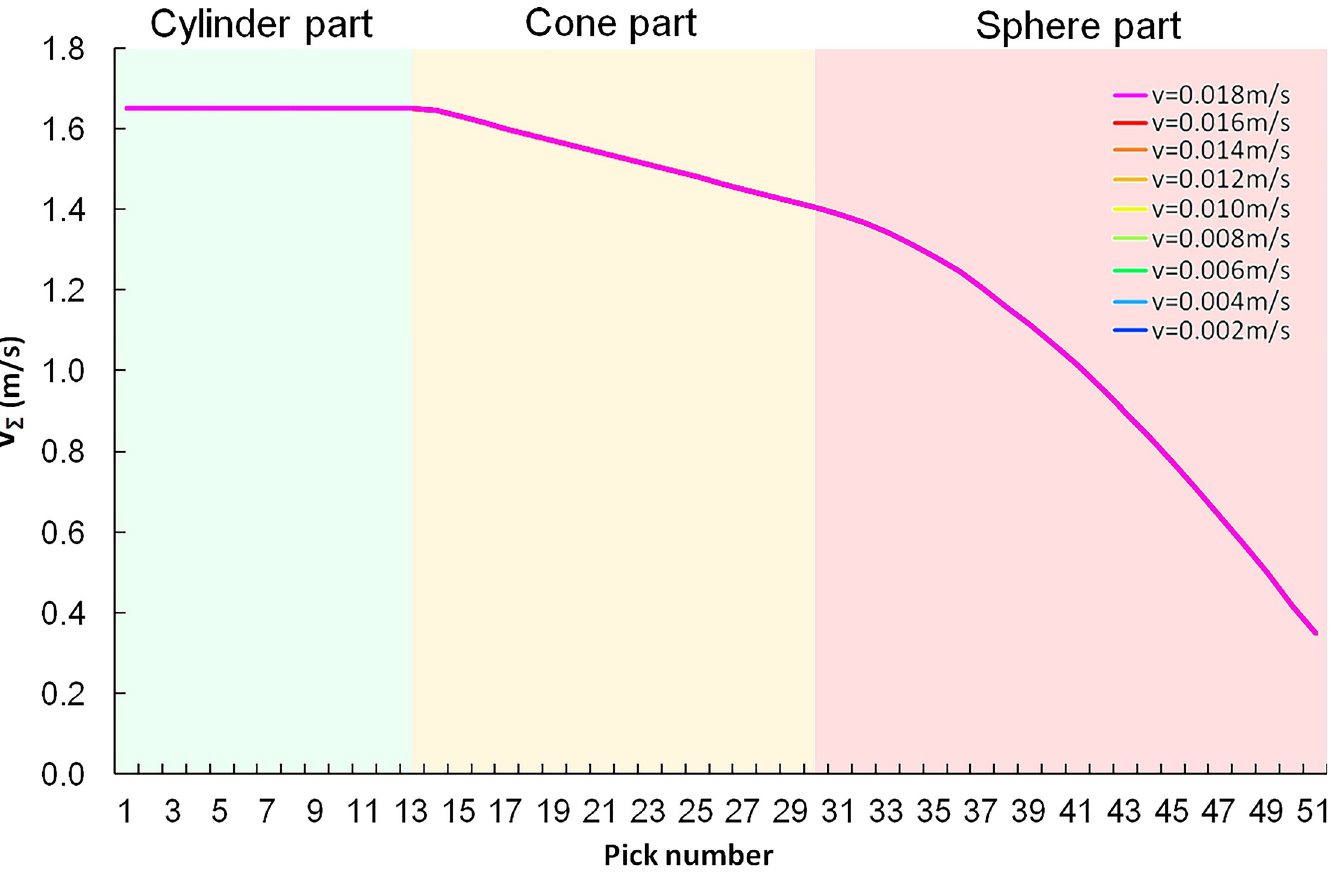
Fig 20. Cutting speed of each